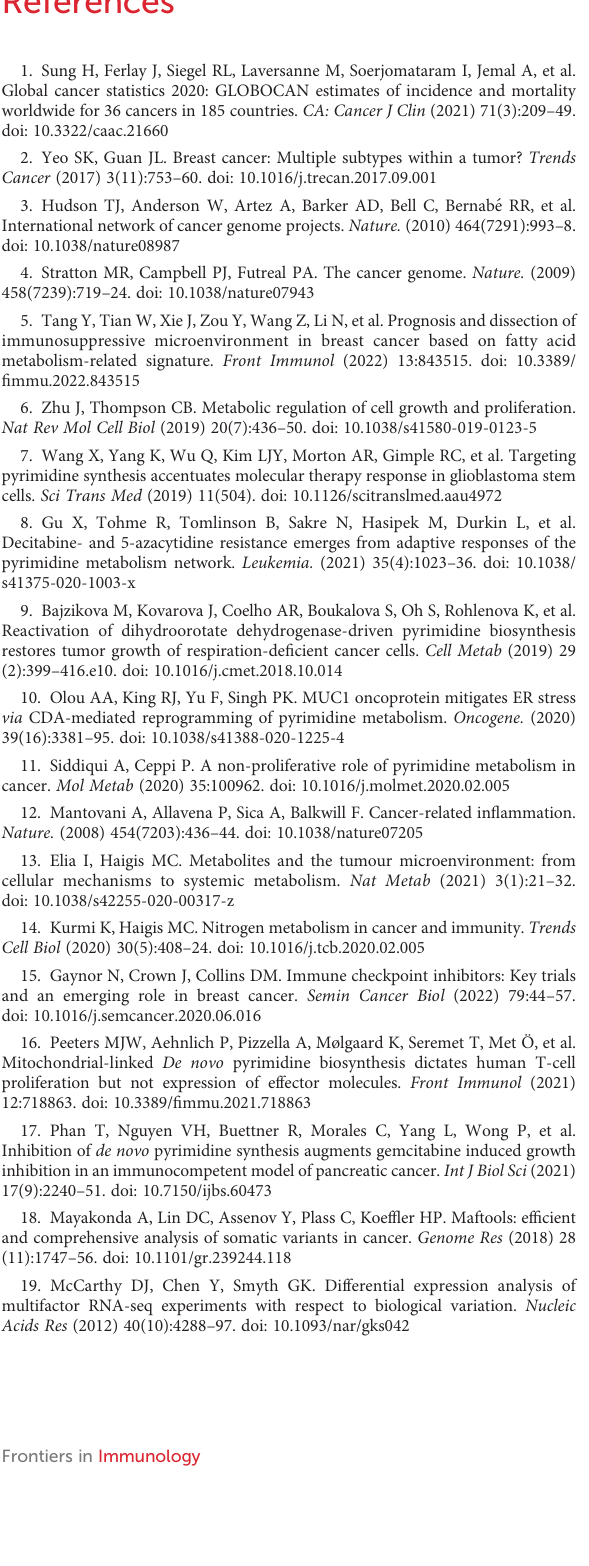
SUPPLEMENTARY FIGURE 3 The mRNA expression level of immune checkpoints in the METABRIC (A) and GSE96058 (B) . SUPPLEMENTARY FIGURE 4 The TME landscapes between high- and low-PMI groups were estimated in the two validation sets. The boxplots were applied to display the in fi ltration context of 22 immune cells in METABRIC (A) and GSE96058 (B)